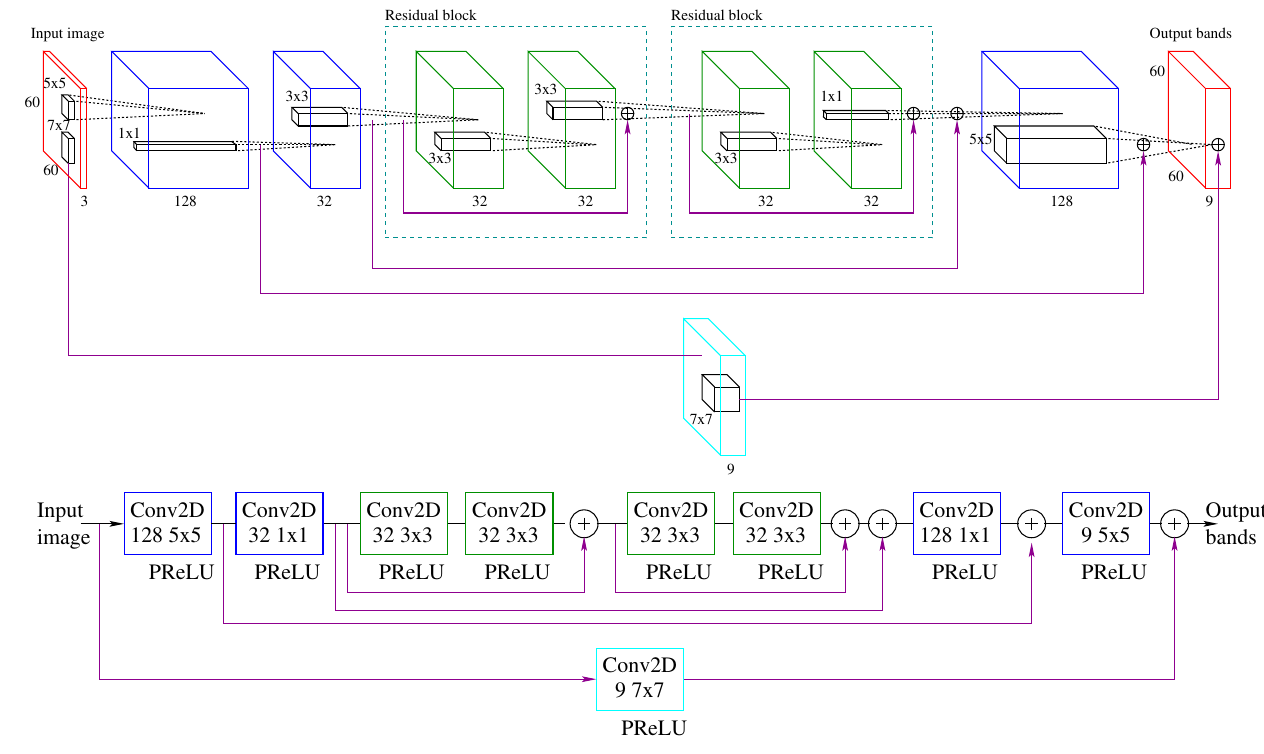
Figure 7. ResNet model considered as generator for a Conditional Generative Adversarial Network architecture. The upper part of the figure shows the feature maps, while the lower part indicates the operation that is carried